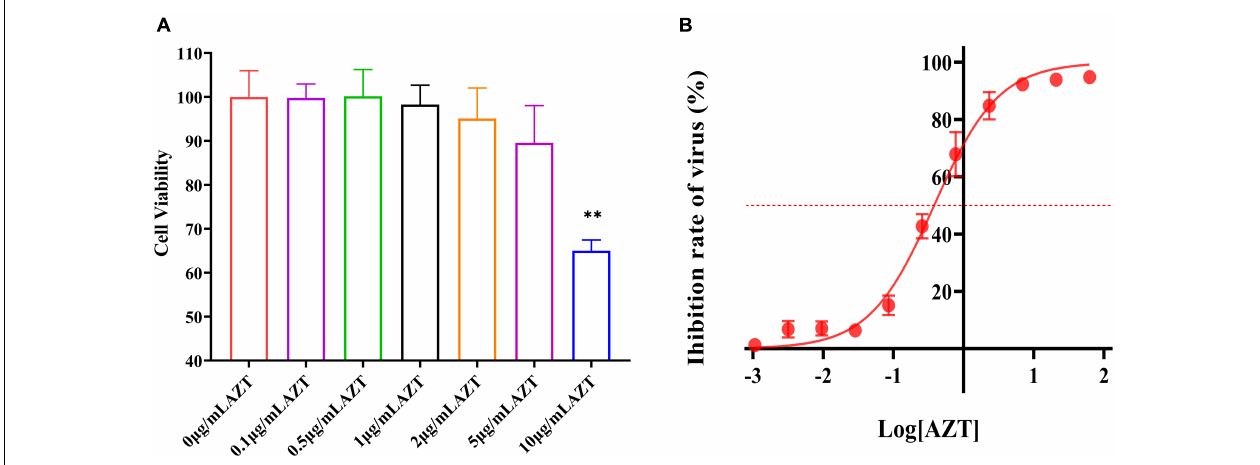
FIGURE 2 | Antiviral effect and cell viability of AZT at different concentrations. (A) Cell viability of DF-1 cells after AZT treatment at 0.1, 0.5, 1, 2, 5, and 10 µ g/ml for 48 h by CCK-8 assay. The experiment was repeated three times. The error bars represent the SD. ∗∗ P < 0.01 and ns represents not statistically significant. (B) Dose-response curve of AZT reveals the dose relationship between AZT and ALV-J. The x -axis represents the log of the concentration of AZT ( µ g/ml), and the y -axis represents the inhibition rate of virus (%), which was calculated according to Equation 2 and represents the proportion of virus titer reduction under drugs. The red dotted line indicates the position of 50% inhibition rate. The experiment was repeated eight times. The error bars represent the